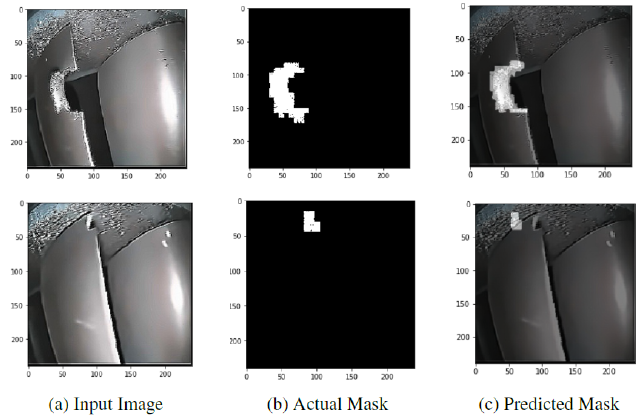
Figure A5. FL segmentation on test data after 300 epochs.